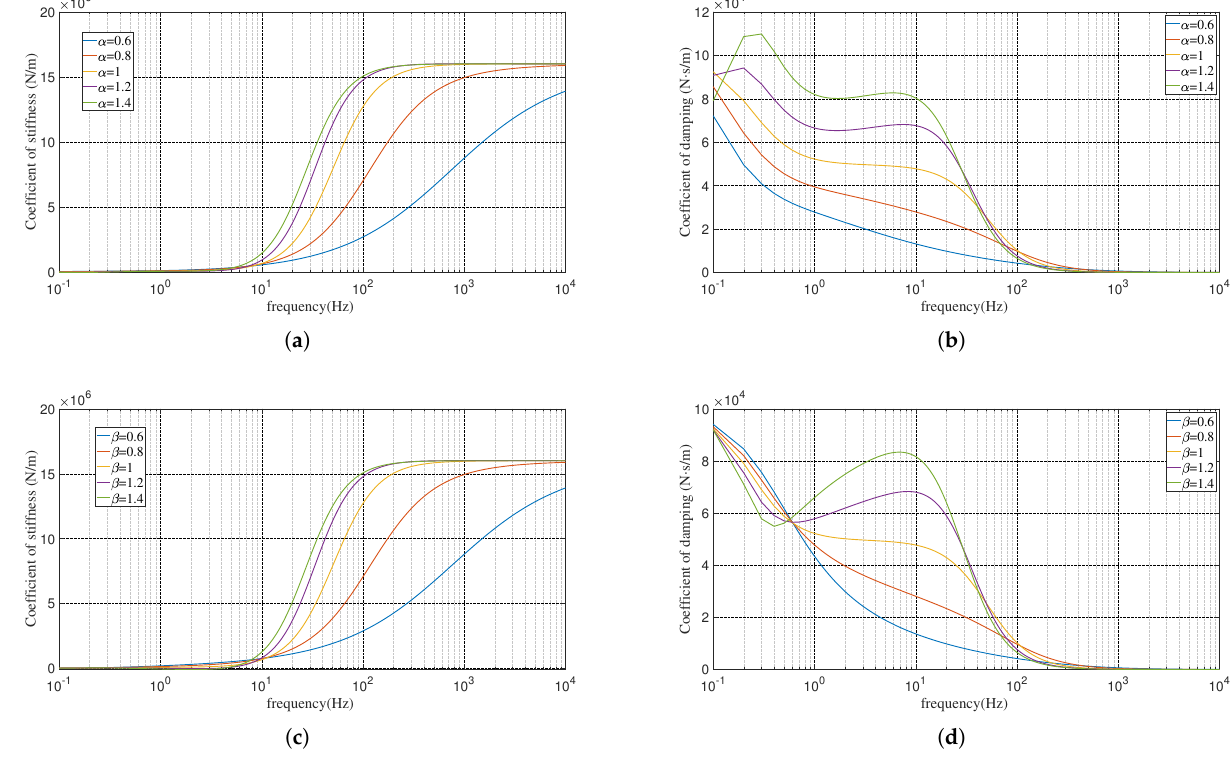
Figure 12. Effect of the fractional order on the dynamic characteristics of the FOBGF model. ( a ) Change of dynamic stiffness with the α order. ( b ) Change of damping with the α order. ( c ) Change of dynamic stiffness with the β order. ( d ) Change of damping with the β